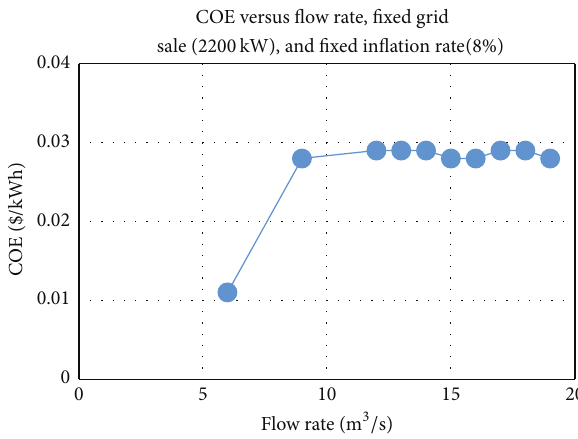
Figure 11: Relation between costs of energy versus variation in design flow rate.